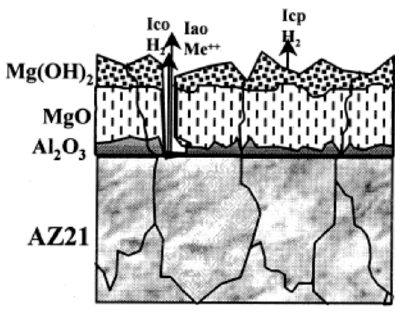
Figure 23. Corrosion interface of AZ21 alloy. Reproduced with permission from [99], Elsevier, 1998.